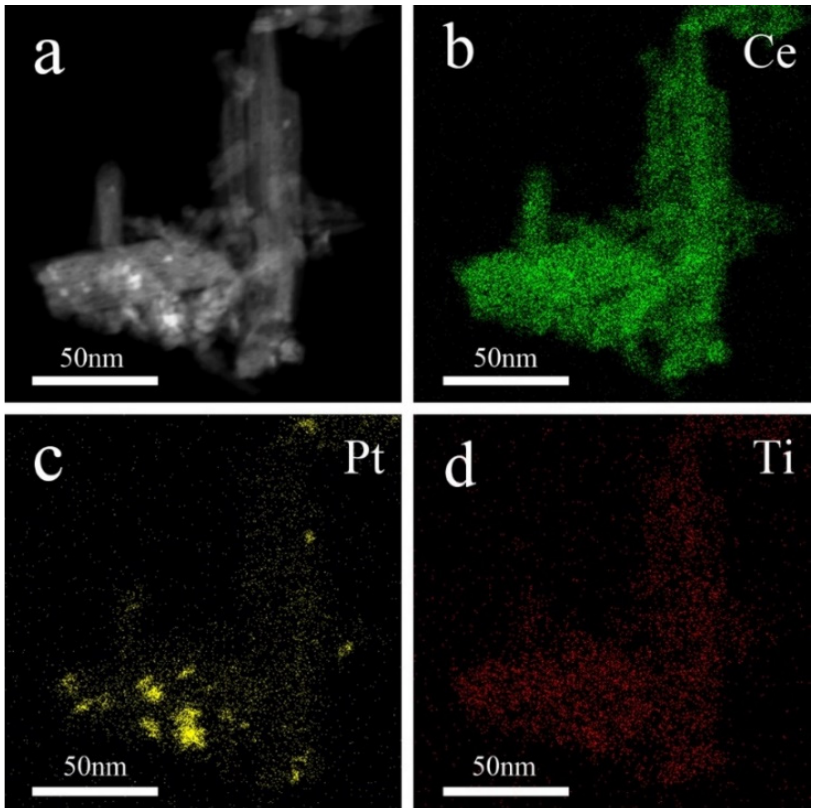
Figure 4. The STEM image of (0.5TiO 2 − Pt)/CeO 2 and element mapping of ( b ) Ce, ( c ) Pt, and ( d ) Ti.